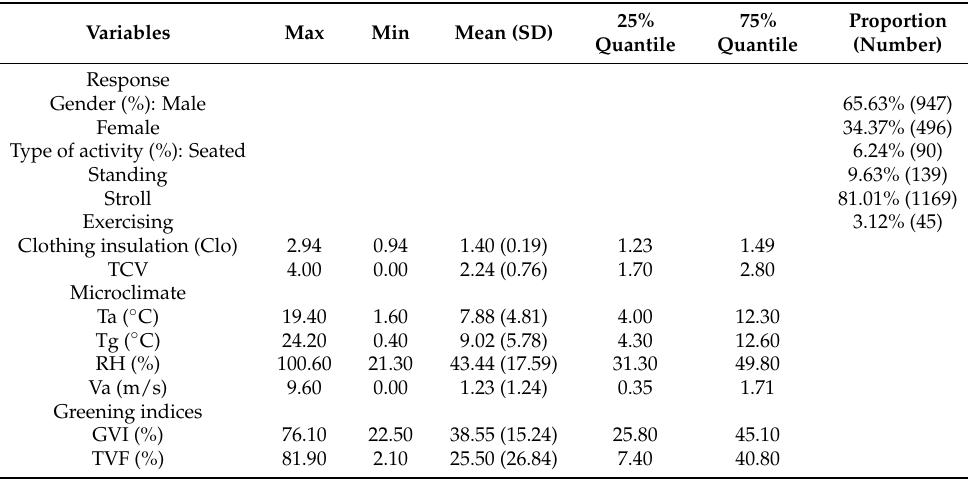
Table 3. Summary statistics of the data.